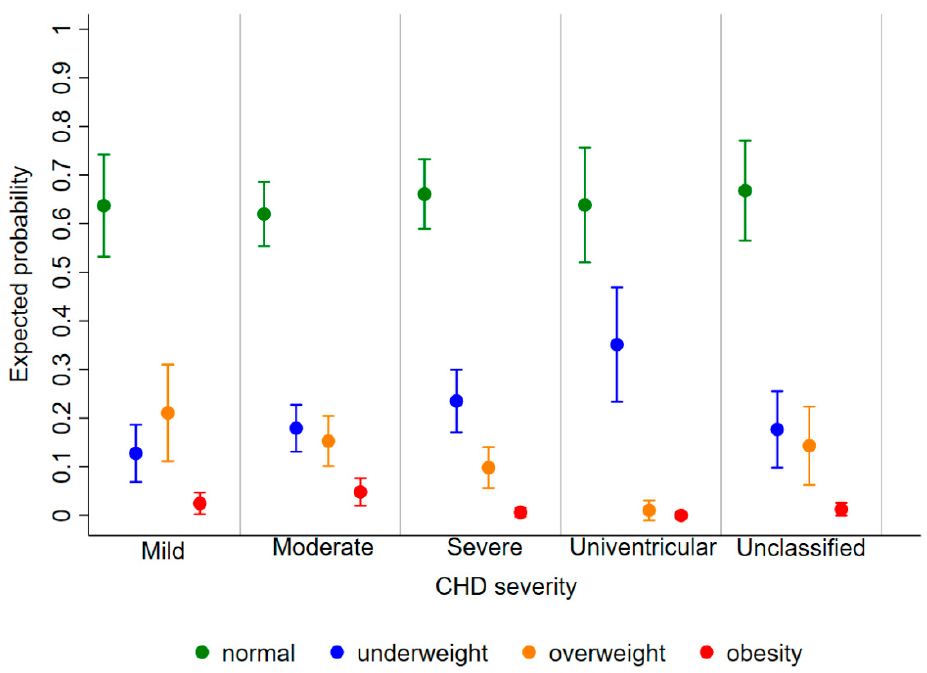
Figure 4. Expected probability of underweight (blue), normal weight (green), overweight (orange), and obesity (red) according to CHD severity.